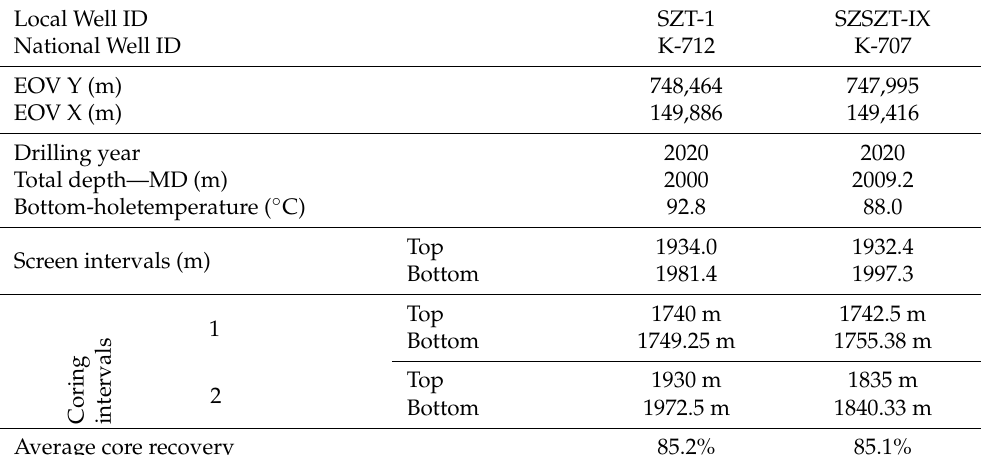
Table 2. Well parameters and coring properties of boreholes SZT-1 and SZSZT-IX.